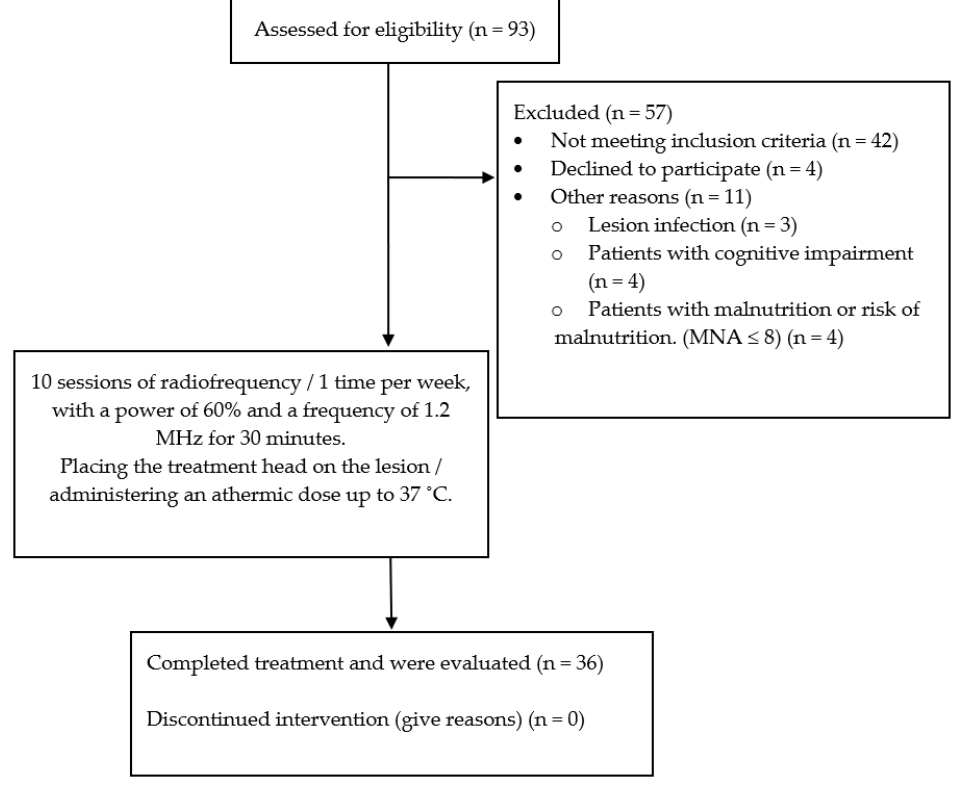
Figure 1. Flow chart of the study.